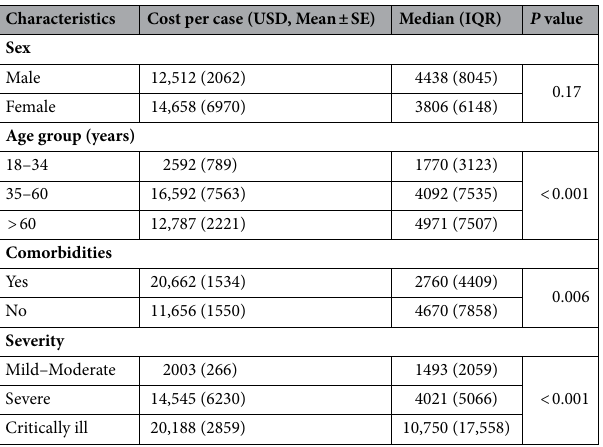
Table 2. Cost for clinical management of COVID-19 patients stratified by various demographic and clinical